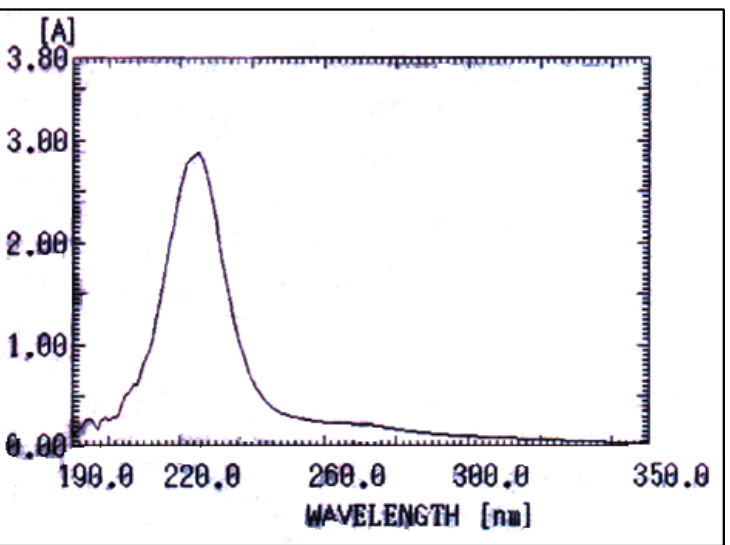
Figure 6. UV–Vis spectra of PHB extract of A. faecalis RZS4 obtained from NDM and extracted with acetone:alcohol.